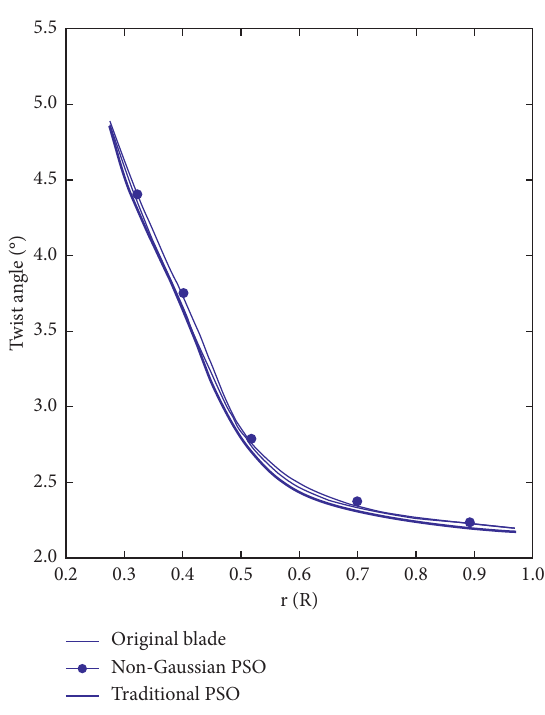
Figure 3: Comparison of blade twist angles.